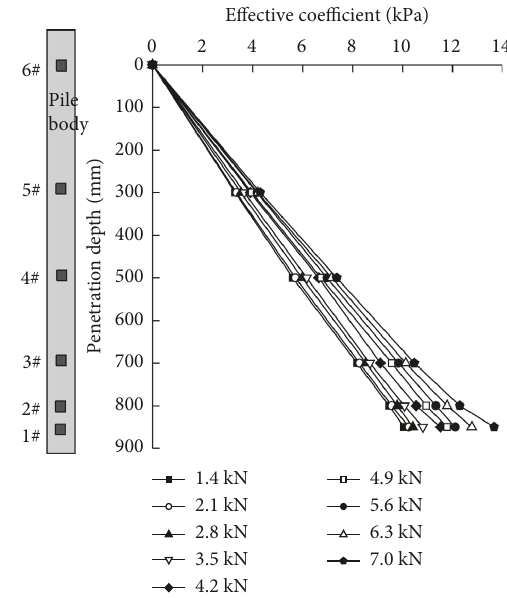
Figure 11: Variation curve of effective earth pressure of TP2 with depth under various loads.